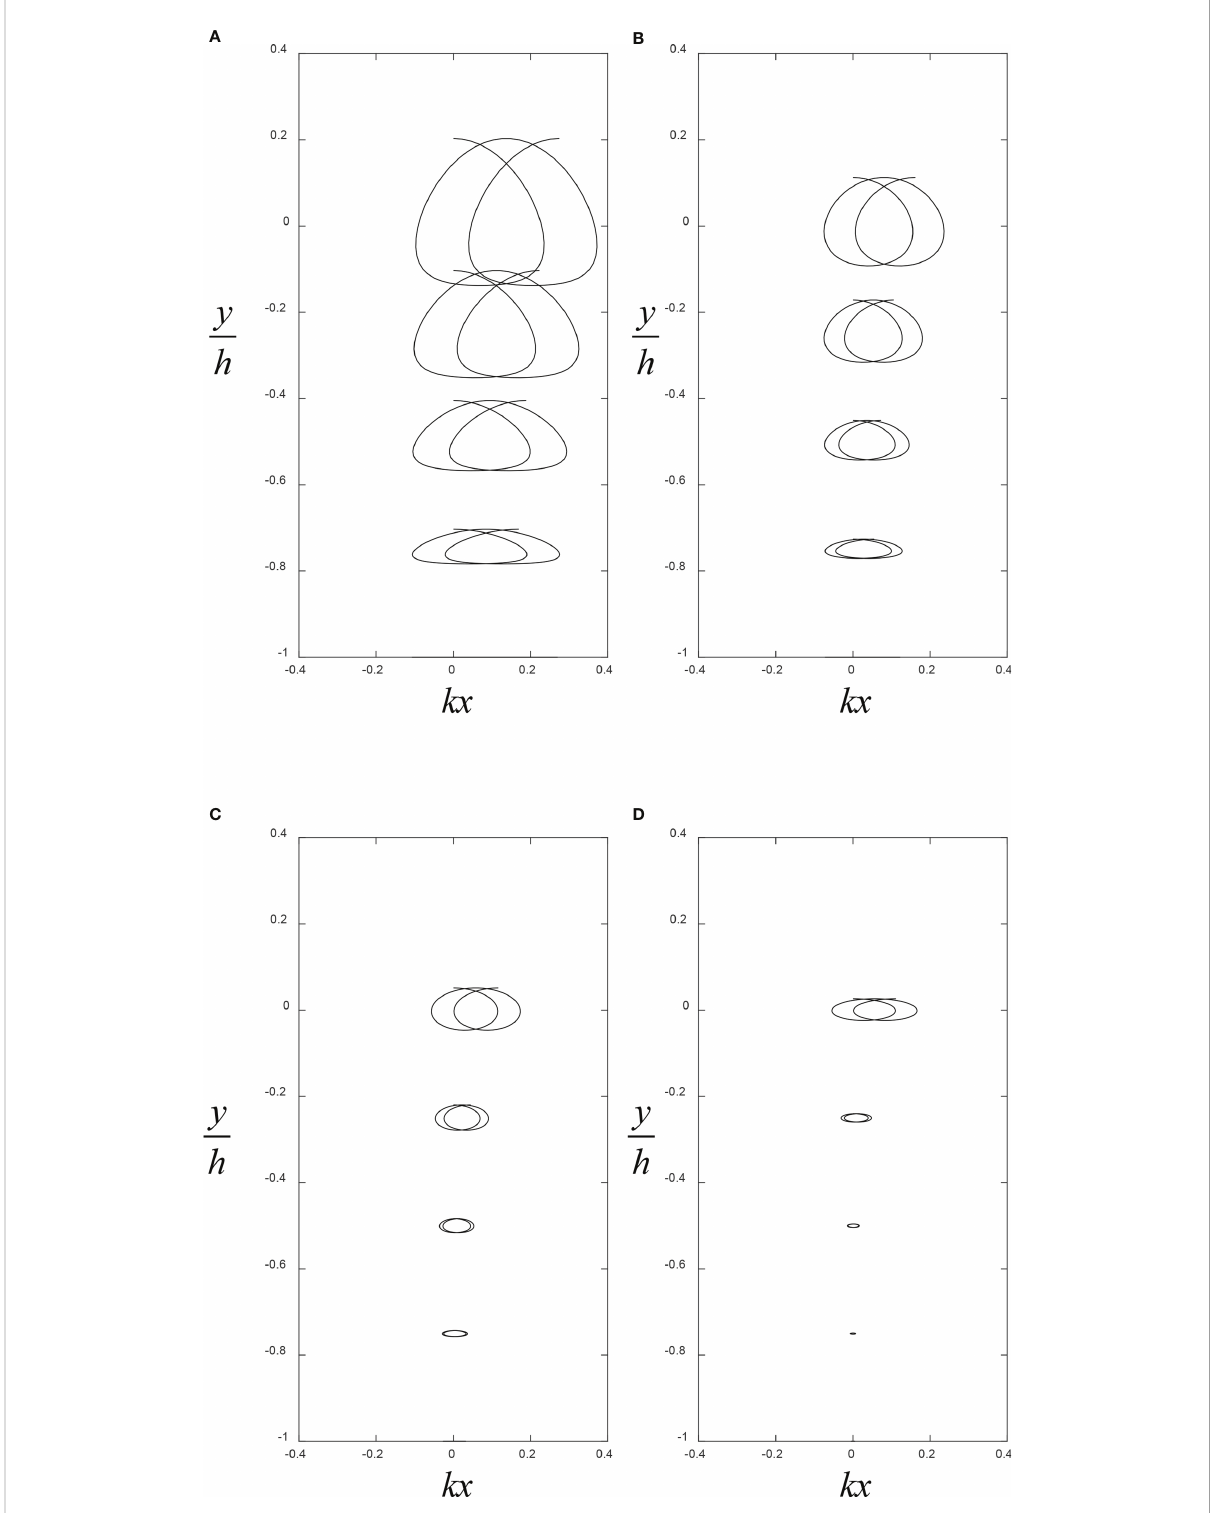
FIGURE 2 (A – D) The variation of third-order water particle trajectories at different vertical labels b for the thickness of the ice sheet d = 1 m under various water depths h = 10, 20, 50, 100